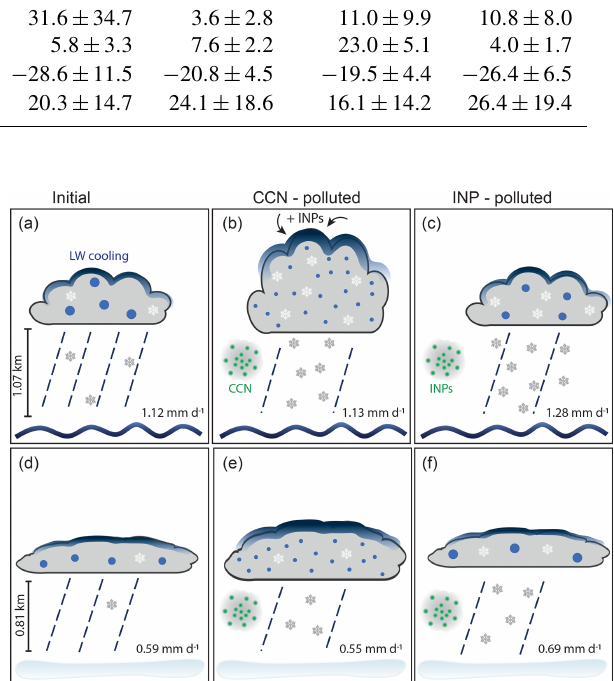
Figure 11. Conceptual overview of the cloud response to increased CCN and INP concentrations. The first row illustrates the open ocean stratocumulus regime (a, b, c) , the lower row the stratus over sea ice (d, e, f)